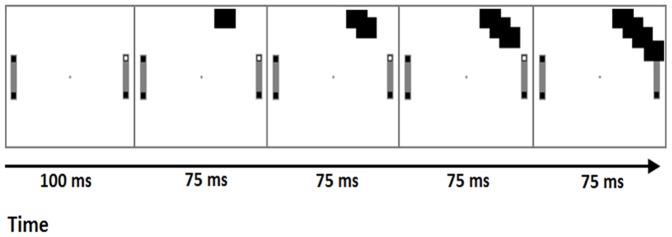
Trial sequence in Experiment 2.